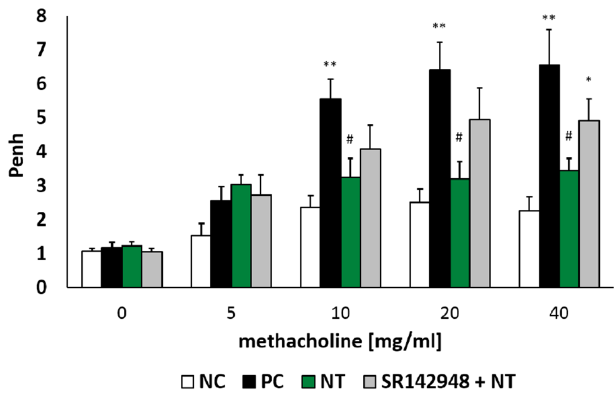
Figure 1. Airway responsiveness (Penh) to increasing concentrations of methacholine (5, 10, 20, 40 mg/ml). Effect of treatment with Neurotensin (NT) alone and NT pretreated with SR 142948 in dinitrofluorobenzene (DNFB)-sensitized/ dinitrobenzene sulphonic acid (DNS)-challenged mice. Comparison to DNFB-sensitized/DNS-challenged group (positive control; PC) and vehicle- sensitized/DNS-challenged group (negative control; NC) treated with NaCl. The results are presented as means ± SEM; n = 6–7 mice per group. * p < 0.05, ** p < 0.01 compared with the NC group, # p < 0.05 compared with the PC group.